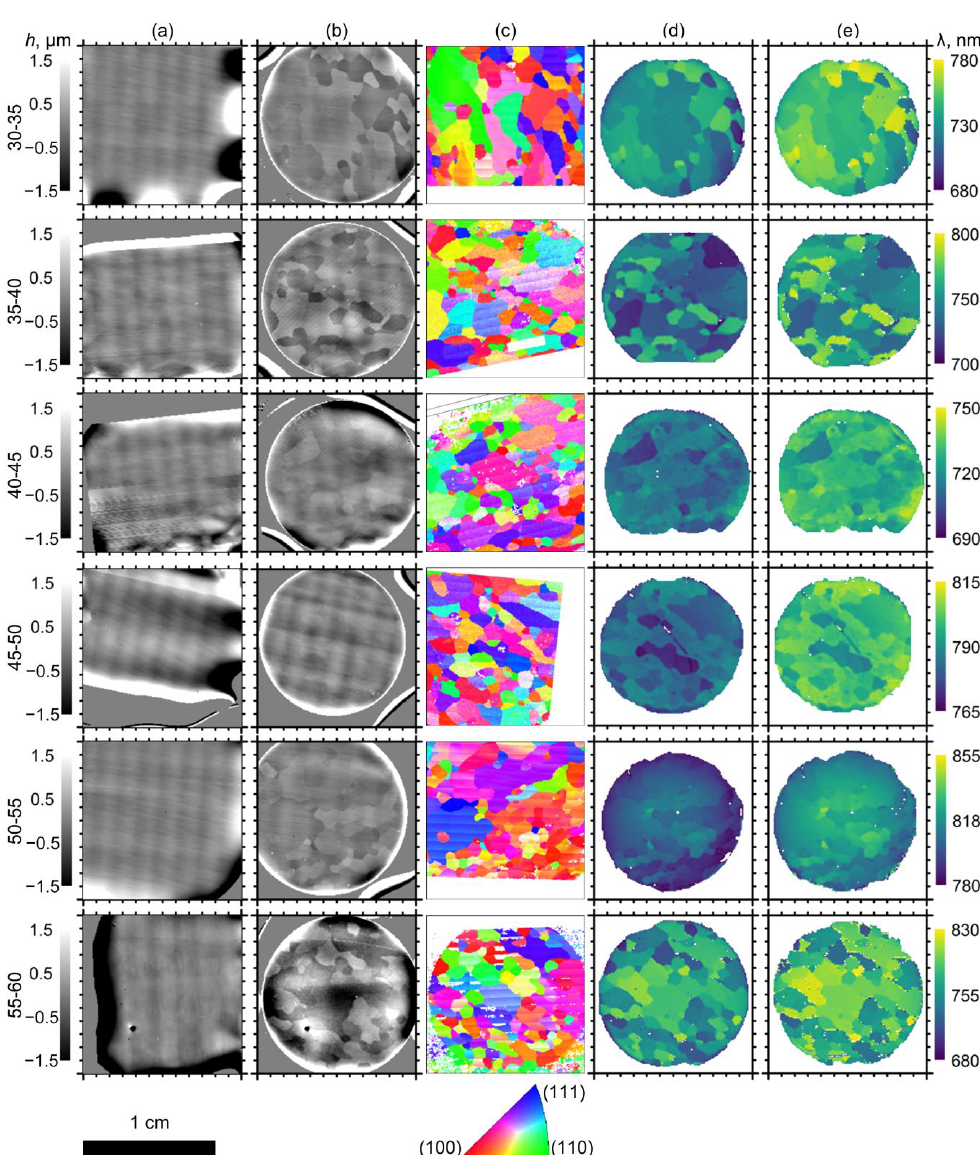
Figure 2. The mosaic of AAO PhCs obtained by anodizing of polycrystalline Al substrates. Height ( h ) maps of the surface of polycrystalline Al substrates before ( a ) and after ( b ) the first anodizing. ( c ) EBSD maps of the surface of polycrystalline Al substrates. The colours refer to the orientations shown by the inverse pole figure for the normal direction. Maps of the central wavelength (λ) of the photonic band gap (PBG) for ( d ) dry and ( e ) wet PhCs. The data in rows correspond to samples 30 – 35, 35 – 40, 40 – 45, 45 – 50, 50 – 55, and 55 – 60. All maps have a lateral size of 12 × 12 mm 2 . White arrows in the panels (b – d) for the sample 30 – 35 show the region of interest for detailed study (see Figure 3).